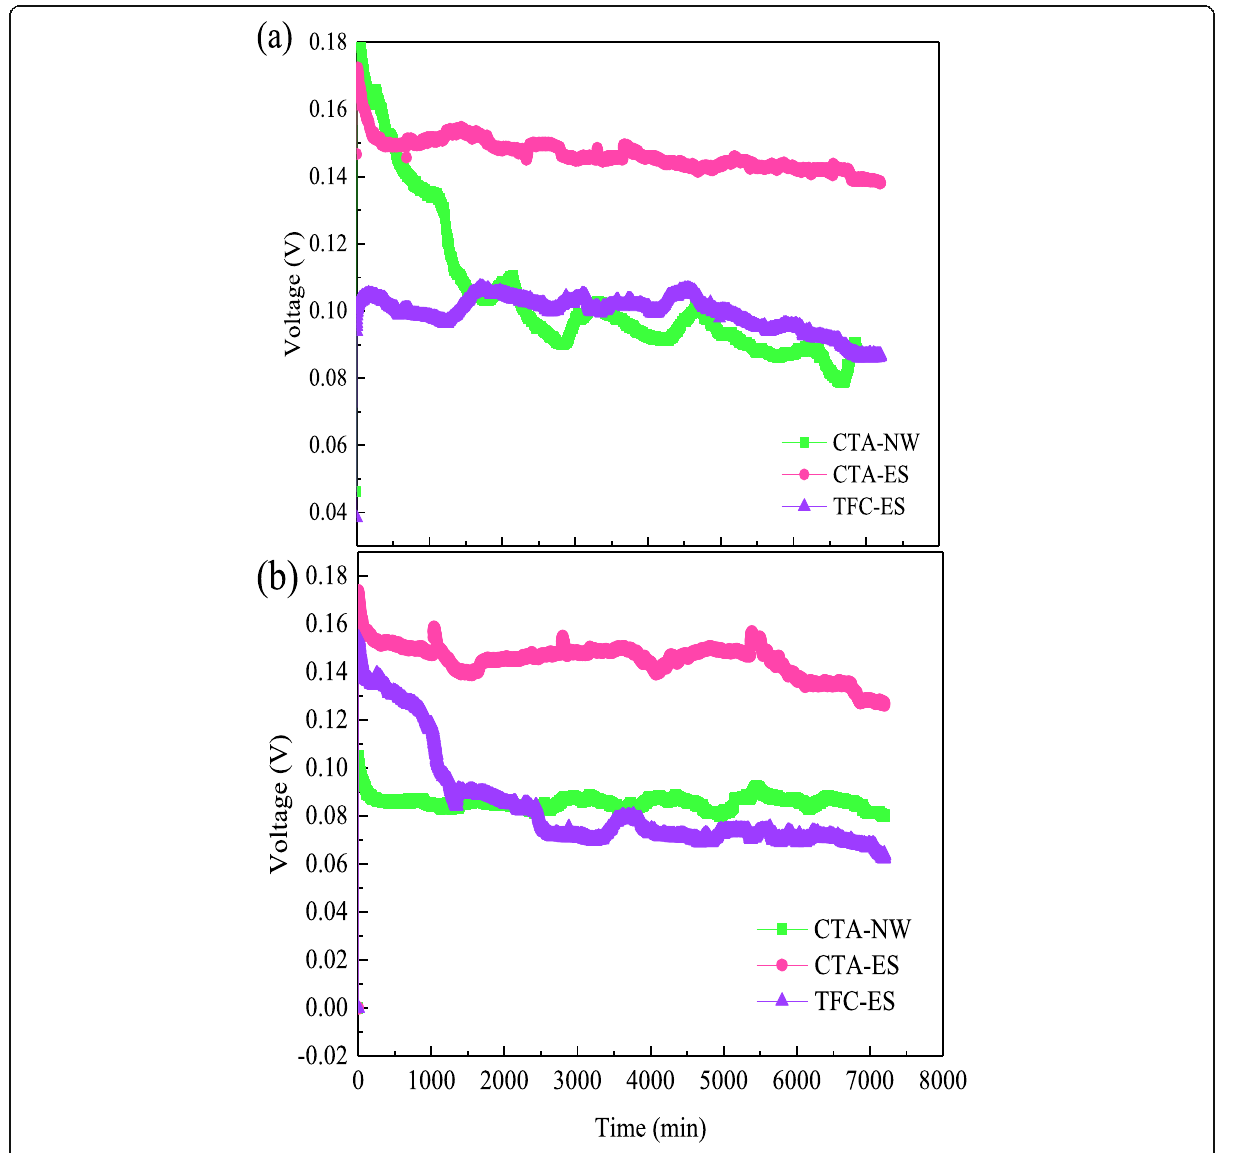
Fig. 1 Voltage outputs versus operation time for OsMFCs fed with leachates under AL-FS mode ( a ), AL-DS mode ( b